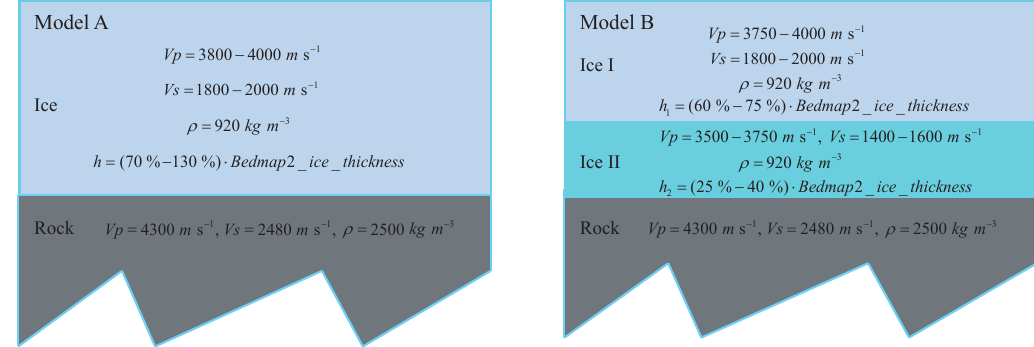
Figure 2. Sketches of the two ice layer models used for H / V spectrum inversion. Model A comprises a single ice layer, while model B is a two-layer ice structure with low shear-wave velocity in the lower ice layer. The parameters used in the two models are consistent with Wittlinger and Farra